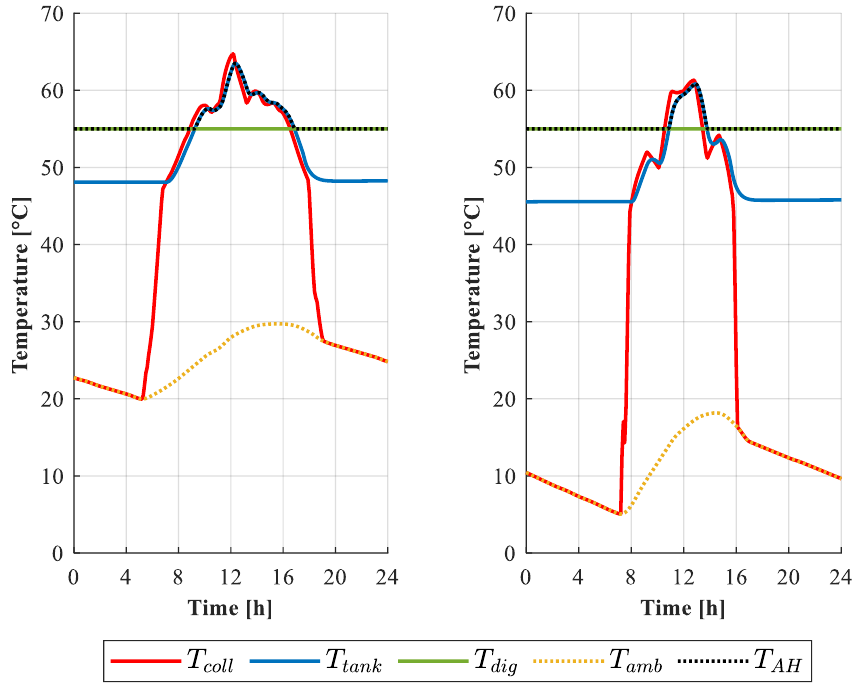
Figure 2. Temperatures for a typical summer ( left ) and winter ( right ) day.